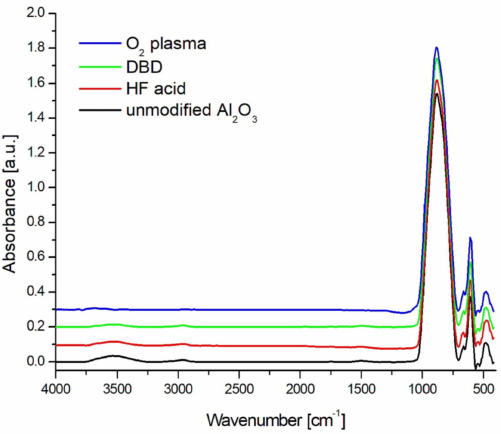
Figure 3. FTIR spectra for unmodified and modified ceramics using 5% HF acid, DBD, and O 2 plasma in the range of 4000–400 cm -1 .